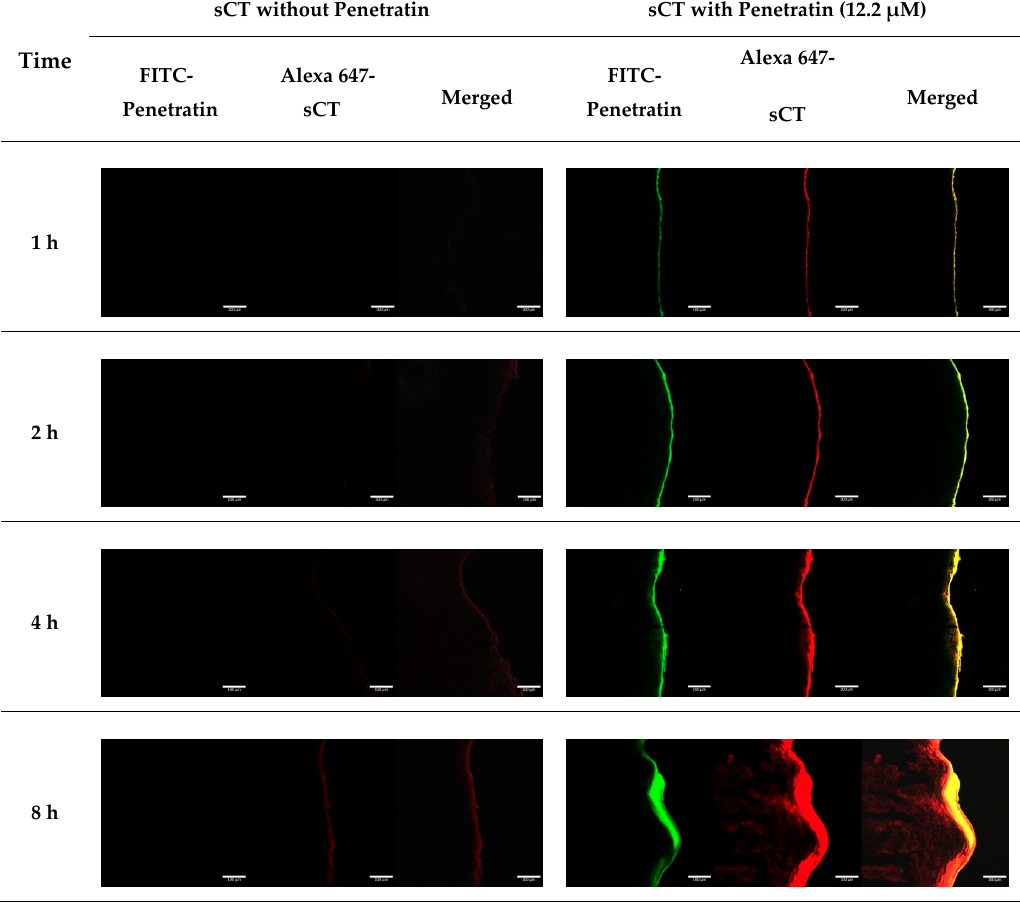
Figure 8. CLSM images of FITC-Penetratin and Alexa 647-sCT internalization in buccal tissues at